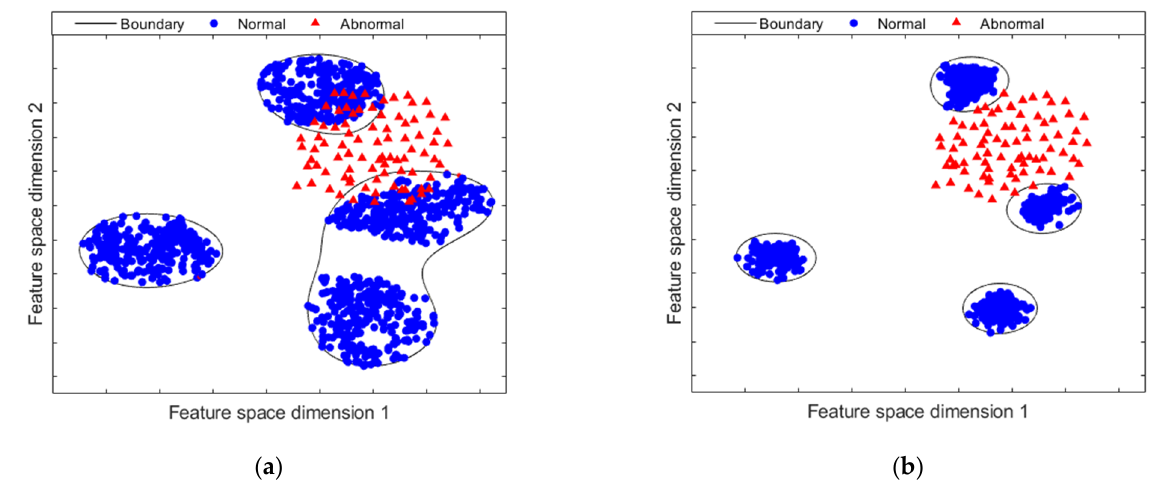
Figure 1. Feature space mapping: ( a ) The feature space mapping without a compact representation shows a high overlap between both classes; ( b ) feature space mapping with an improved and compact representation. It shows a higher separation between normal and abnormal samples.